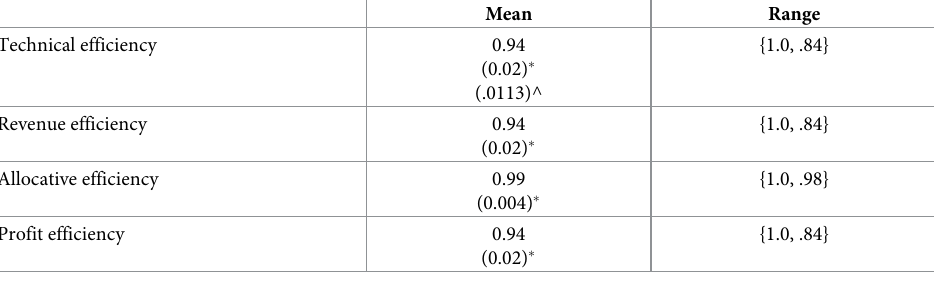
Table 2. Summary bull efficiency estimates from free disposal hull analysis (fat and protein as outputs, semen as